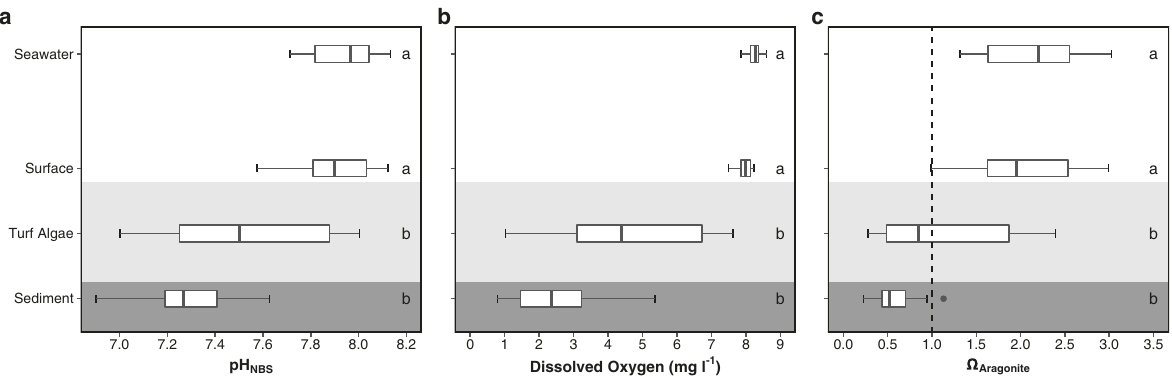
Fig. 4 Spatial variability of the carbonate chemistry and dissolved oxygen associated with the turf algae. Box plots ( n = 15 biologically independent locations) of a pH NBS , b dissolved oxygen (mg l − 1 ), and c aragonite saturation state of seawater ( Ω ). Sediment = sediment below the turf algal mat (indicated by darkly shaded region), Turf Algae = middle of the turf algal mat (indicated by lightly shaded region), Surface = surface of the turf algal mat, Seawater = water column 2 – 3 m above the turf algal mat. Note that on c aragonite dissolution is favoured below Ω = 1 (dashed line). For the boxplots, the line inside indicates the median, the upper and lower hinges correspond to the interquartile range, and the upper and lower whiskers extend to the highest and lowest values that are within 1.5 × the interquartile range of the hinge. Outliers beyond these whiskers are indicated with a point. A signi fi cant difference between the locations is indicated with a different letter (Kruskal – Wallis with post-hoc using a Dunn test) on the right of each panel.